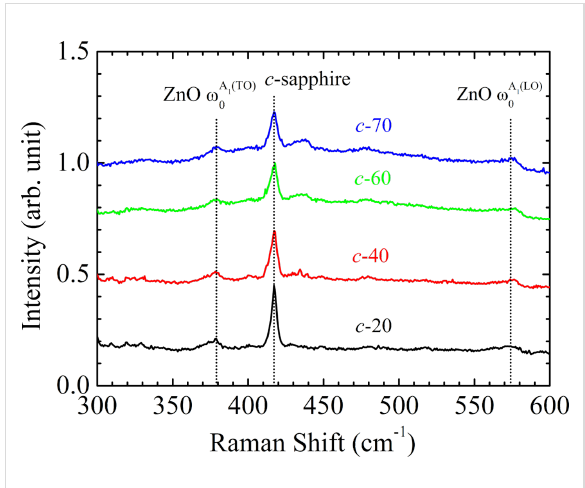
Figure 6: Raman scattering spectra of the four ZnO@B samples. The spectra display A 1 (TO) and A 1 (LO) modes for ZnO. The dotted lines at 379 cm − 1 and 574 cm − 1 show the strain-free A 1 (TO) and A 1 (LO) modes, respectively, for ZnO [20].